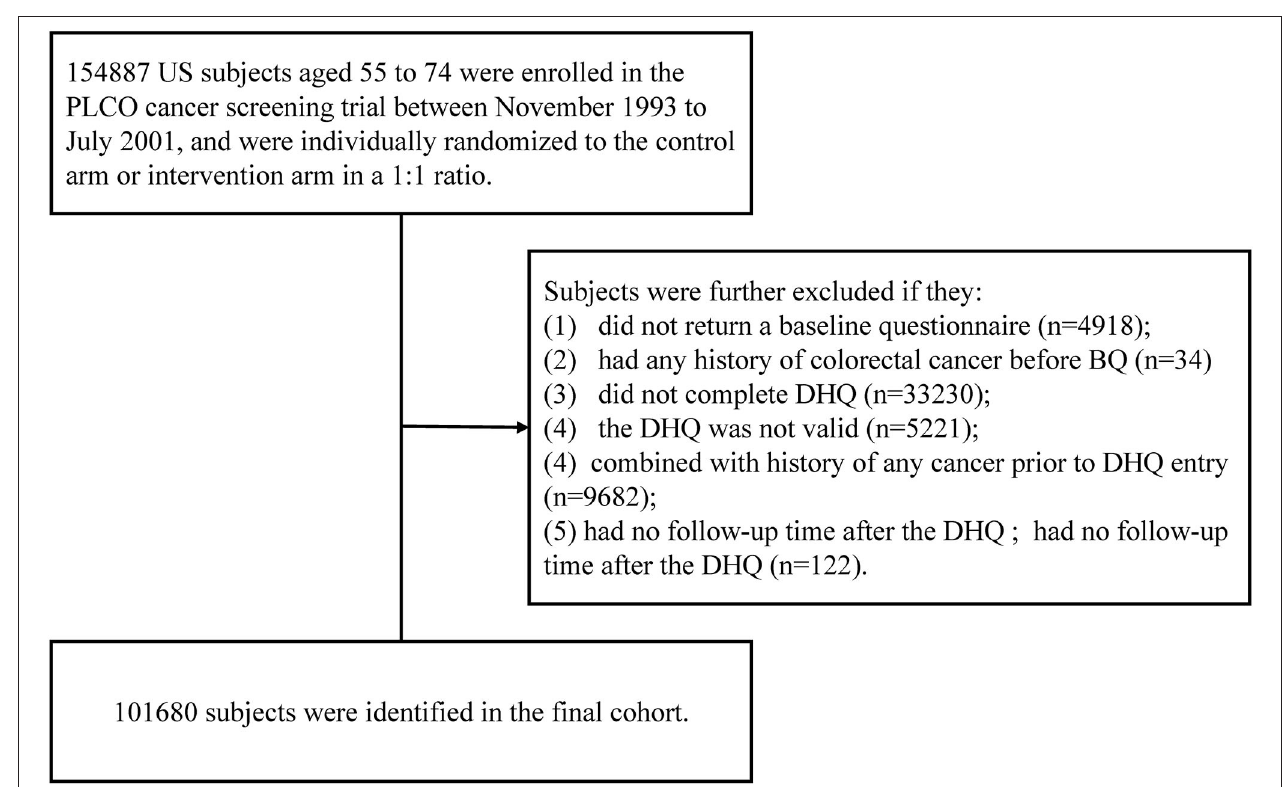
FIGURE 1 | The flow chart of study participants from the PLCO screening